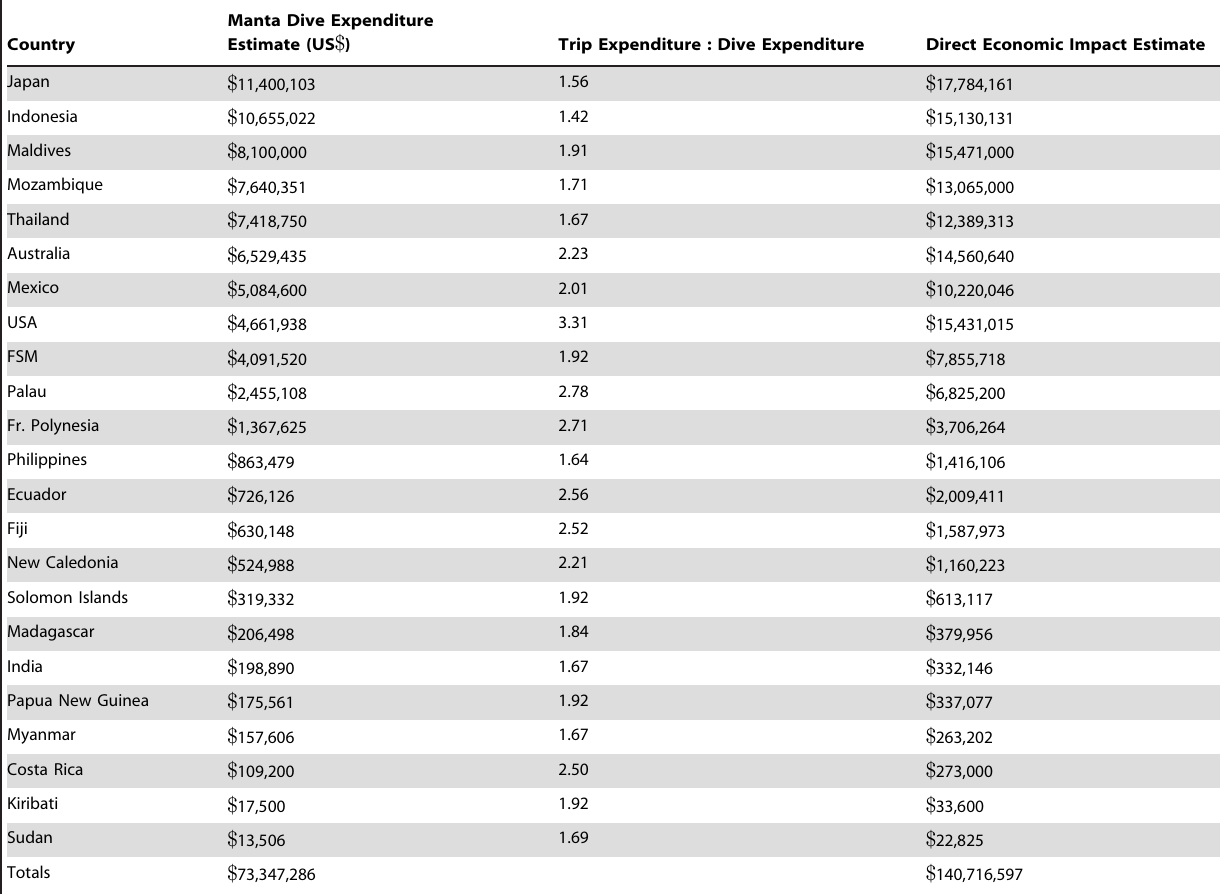
Table 3. Direct Economic Impact of Manta Ray Watching Tourism.